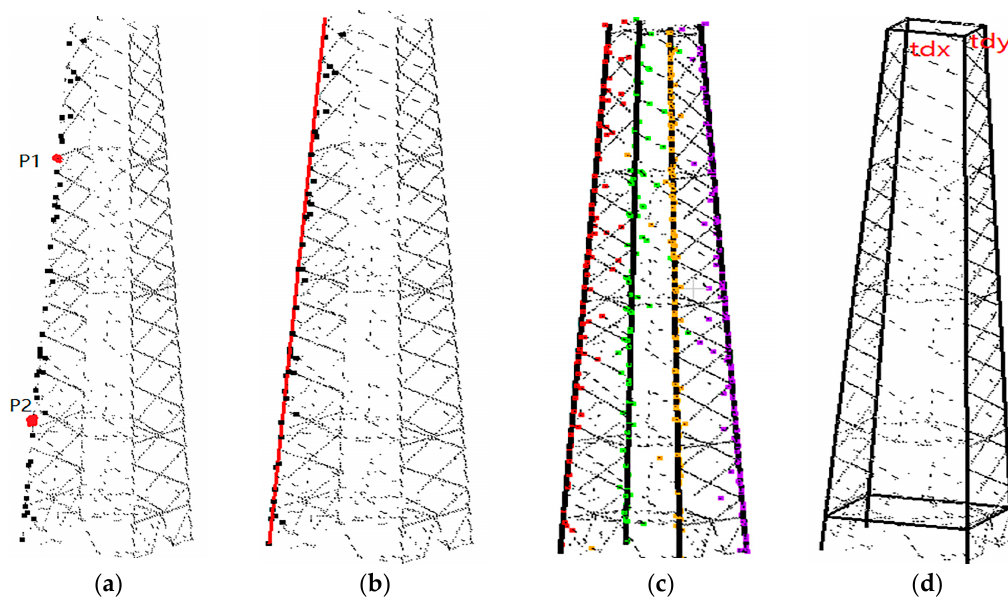
Figure 5. Pylon body reconstruction based on RANSAC: ( a ) corner points of one subset; ( b ) corner line fitting result of one subset; ( c ) fitting results of four corner lines; and ( d ) refined results of the pylon body. The original point cloud is colored in black.